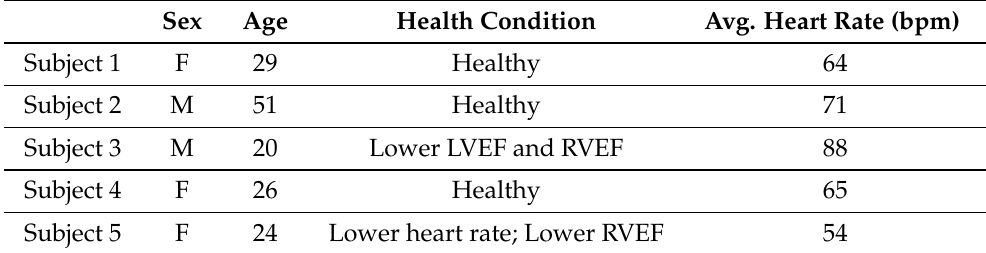
Table 1. Public information of the five subjects involved in this